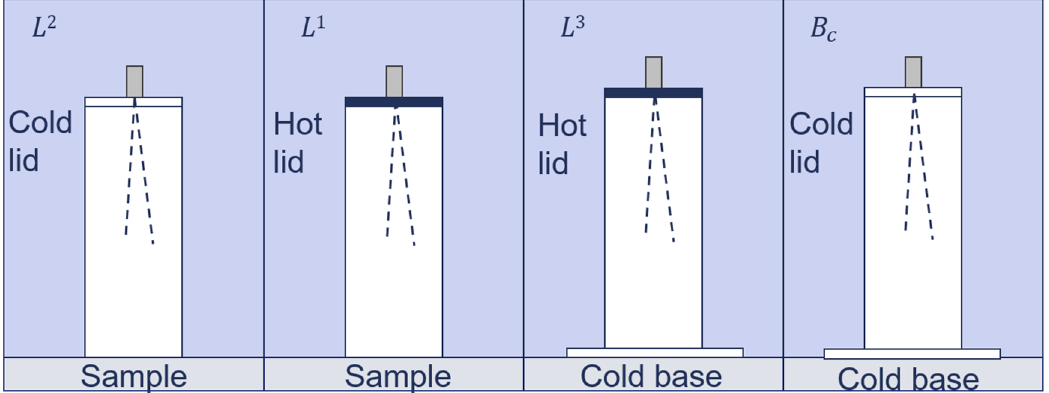
Figure 5. Radiance measurement sequence for the two-lid variant of the emissivity box method, using nomenclature from Rubio et al. [33]. Measurements proceed from left ( L 2 ) to right ( B c ).